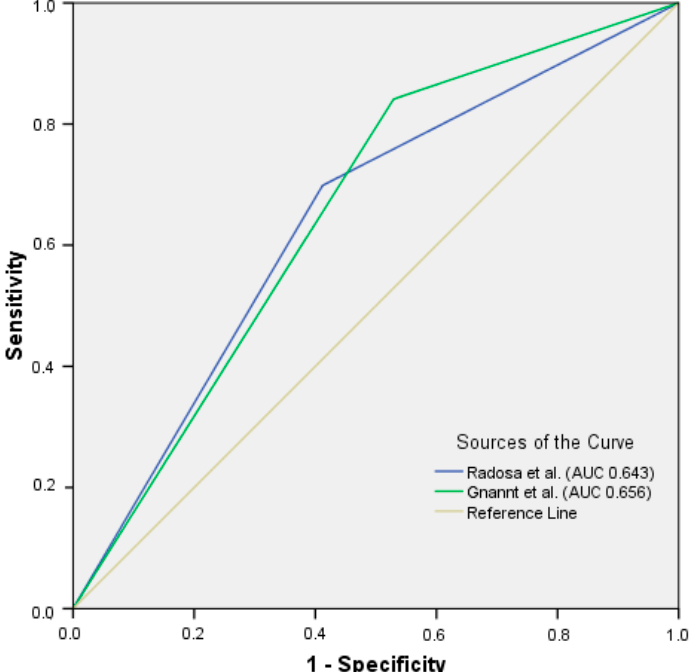
Figure 4. ROC curve for published scoring systems to identify microorganism-containing fluid collections, applied to our cohort.